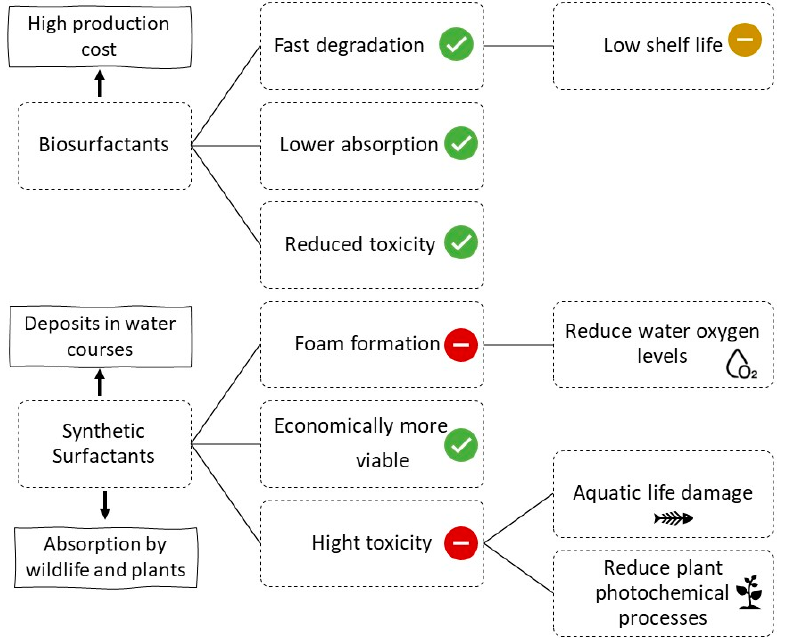
Figure 2. Synthetic surfactants and biosurfactants: comparative advantages and disadvantages.